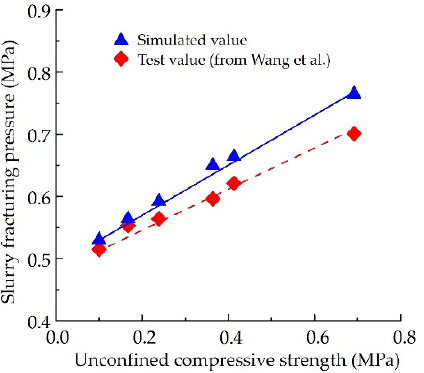
Figure 11. Comparison of simulated values and tests of slurry fracturing pressure under different unconfined compressive strengths [17].